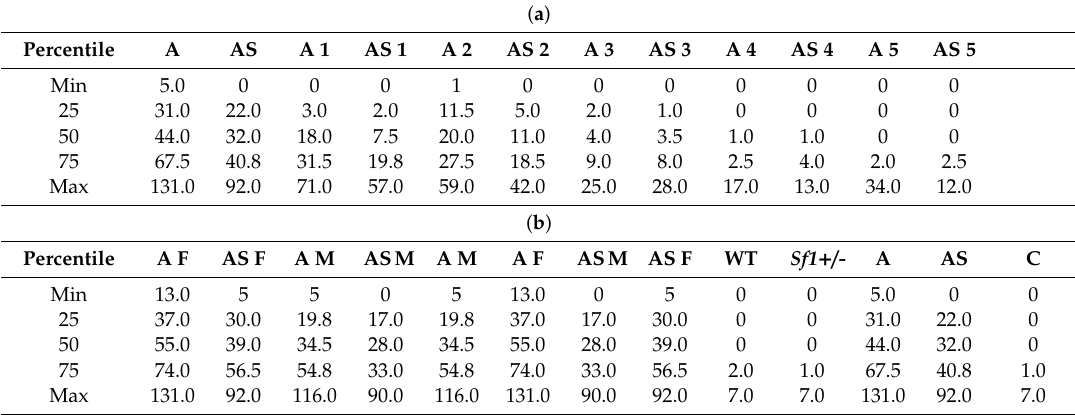
Table 4. Summary of quartile values of box plots. ( a ) Quartile values from Figures 2 and 3. ( b ) Quartile values from Figures 4 and